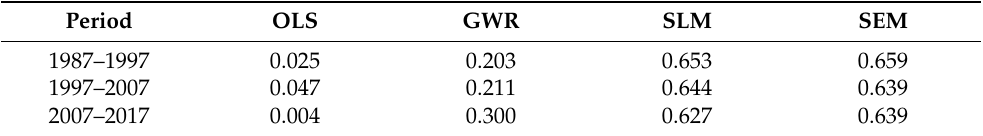
Table 3. Accuracy R 2 value ( p < 0.01) of different models in fitting the effect of LULCC on soil erosion change in different periods.